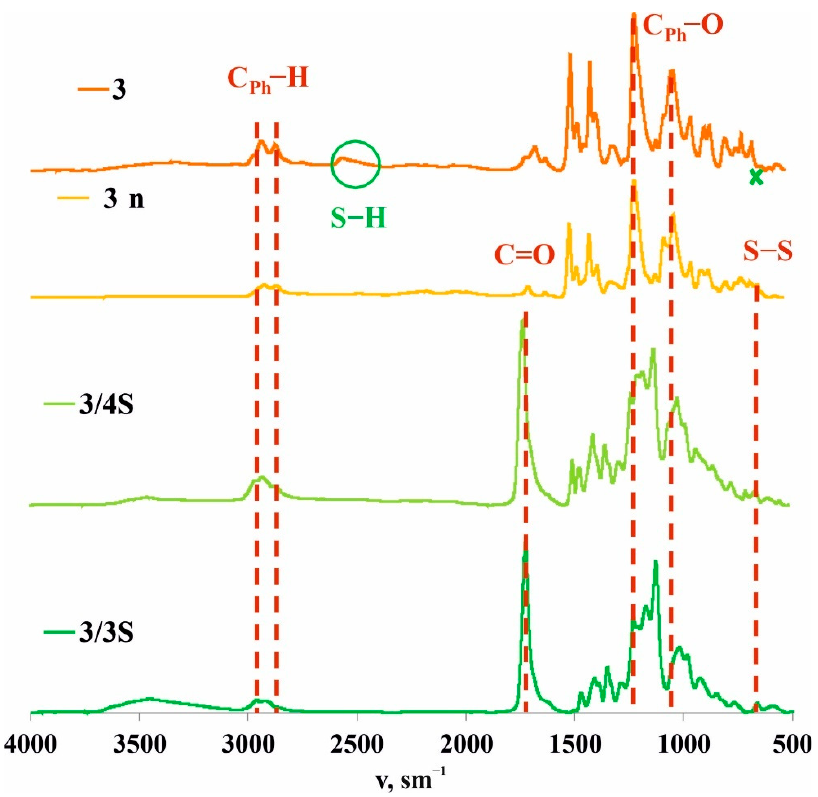
Figure 4. Attenuated total internal reflectance IR spectra of 3 and 3n powders and 3/3Sn and 3/4Sn films.